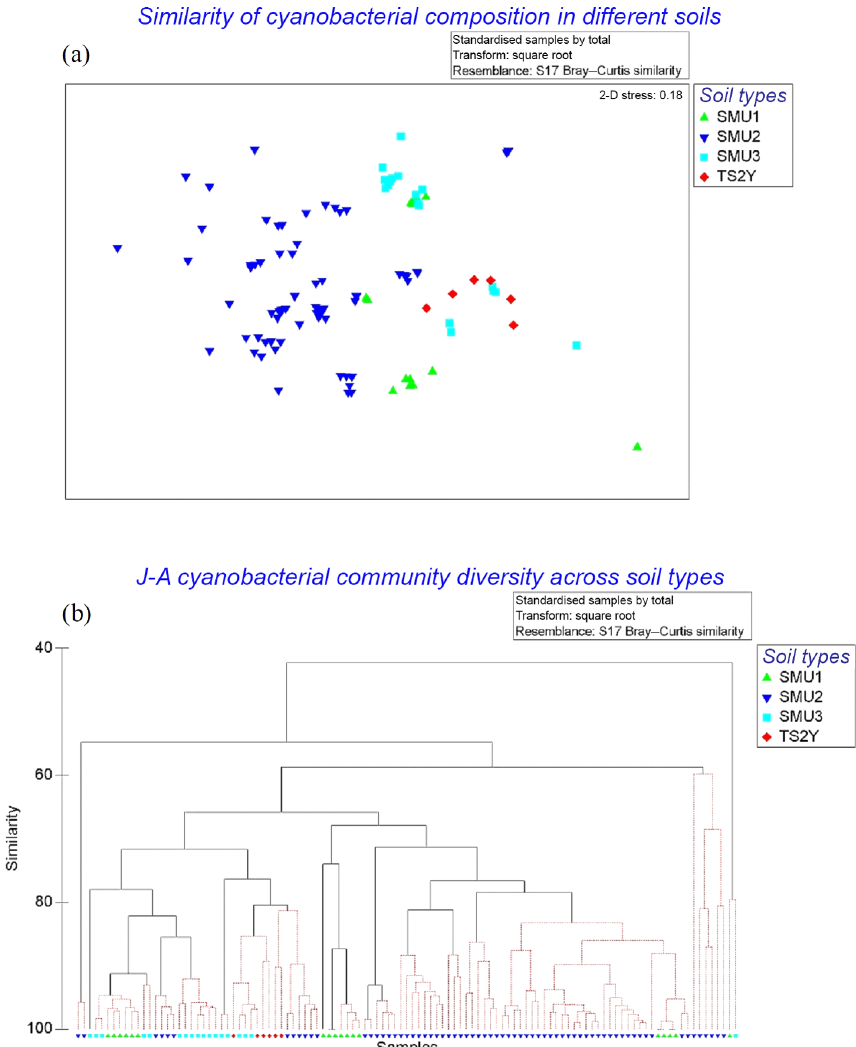
Figure 5. (a) Cyanobacterial community structure based on indexed abundance and diversity across all sites displayed in an nMDS plot (Bray–Curtis similarity). Soil management units represented by SMUs 1–3 and 2-year-old topsoil stockpile (TS2Y). (b) Similarities between samples within their SMU are displayed in a Bray–Curtis dendrogram. Black continuous lines show significant differences between samples ( p = 0 . 05), and lighter lines indicate that most samples were not significantly different to each